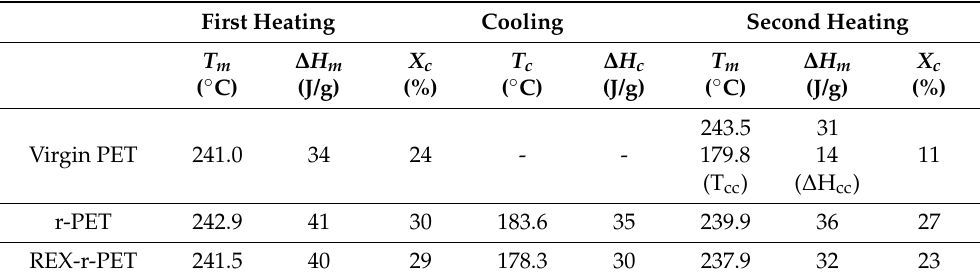
Figure 4. WAXS patterns of the PET samples at 25 ◦ C after nonisothermal crystallization from the melt at a rate of 20 ◦ C/min. Table 3. Thermal properties of the PET samples. All values were obtained from the DSC scans shown in Figure